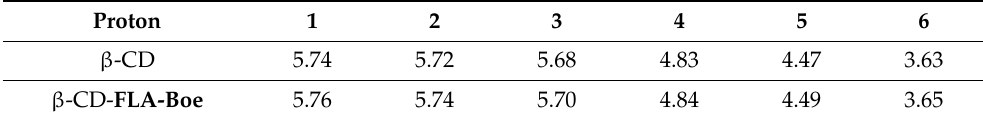
Table 1. 1 H NMR chemical shifts ( δ , ppm) of pure β -CD and β -CD- FLA-Boe .